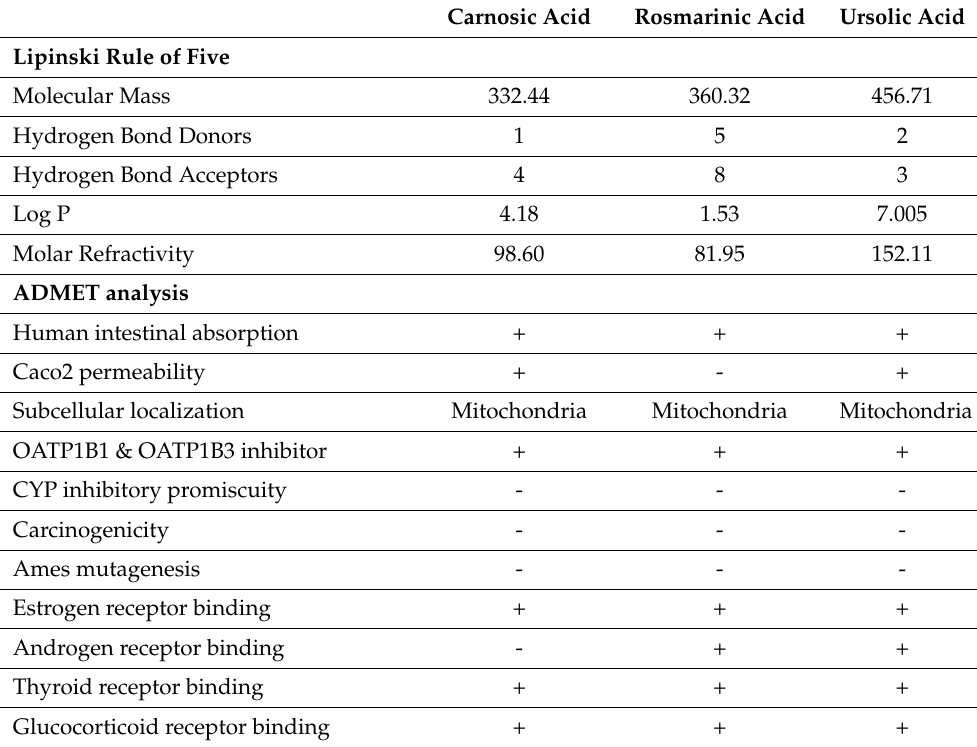
Table 3. Drug likeness of the active compounds of Rosmarinus officinalis